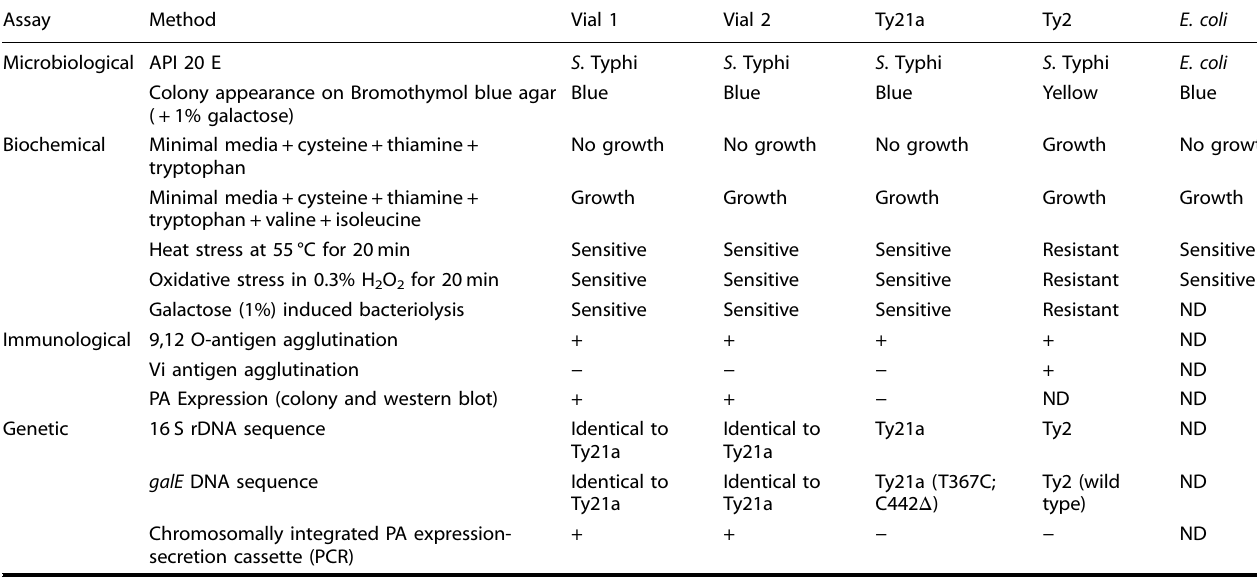
Table 1. Characterization of Ty21a-PA-01 seed bank Assay